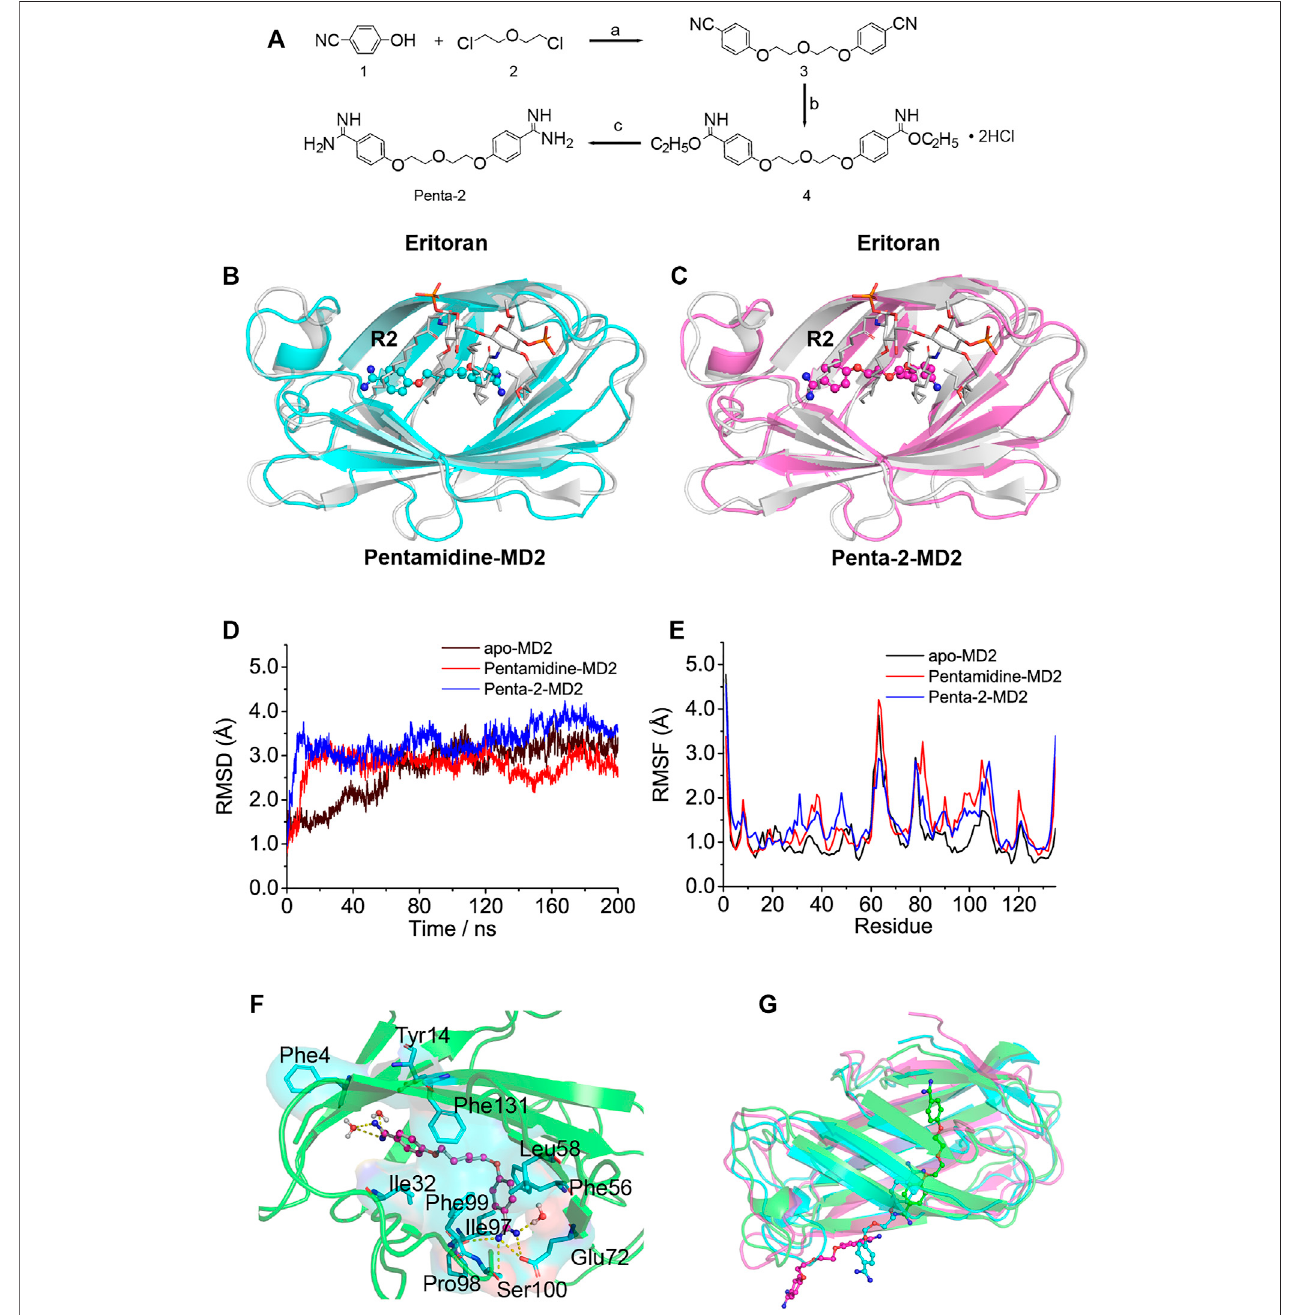
FIGURE 2 | In silico simulation of pentamidine and penta-2 interacting with MD2. (A) Synthetic route for penta-2. Reagents and conditions: (a) K 2 CO 3 , N-methylpyrrolidone, 130 ° C; (b) EtOH, HCl (gas), ambient temperature; (c) EtOH, NH 3 (gas), ambient temperature. (B,C) Overlap of the best docking pose of pentamidine (B) or penta-2 (C) with Eritoran. Eritoran binding location was occupied by pentamidine on its acyl chains R2, and penta-2 on its acyl chains R2. Eritoran – MD2wasextractedfromthehumanTLR4TV3hybridMD2-Eritorancomplex(PDBID:2Z65)afteraligningwithcompound-dockedMD2.MD2wasshown as a cartoon, Eritoran as sticks, and pentamidine and penta-2 as balls-sticks. Eritoran – MD2 was colored as gray, pentamidine – MD2 as green, and penta-2 – MD2 as magentas. (D) Time evolution of the RMSD of MD2 (apo-MD2) and compound bound MD2 (pentamidine – MD2 and penta-2 – MD2) during the MD simulations at 310 K. (E) RMSF ofMD2and compoundboundMD2. (F) Therepresentative bindingmodeofpentamidine withMD2 at310 Kafter molecular dynamic simulation.Pentamidine wasshownasaballs-stickmodel.MD2wasshownasacartoonmodel.KeyresiduesofMD2ininteractingwithligandswereshownasstickandsurfacemodelslabeled with residue names. Hydrogen bonds were shown as dashed lines in yellow. Water molecule interacting with pentamidine was represented as a balls-stick model. (G) Pathwayofpenta-2leavinghydrophobiccavityMD2.MD2wasshownasacartoonmodel,andpenta-2wasshownasaballs-stickmodel.Theleavingprocessofpenta- 2 was shown in the color order of green – blue –